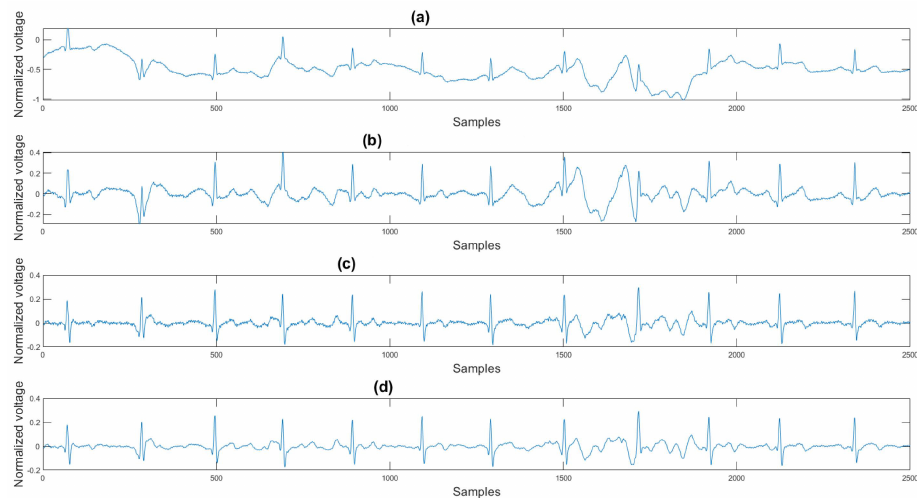
Figure 12. ( a ) Original signal, ( b ) signal after the AEMDR step, ( c ) signal after the adaptive filter step, ( d ) signal after the VMD step.